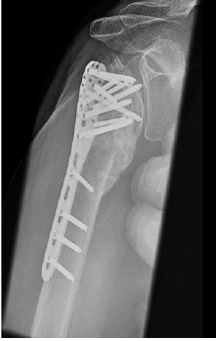
Figure 18. Complication Type 4a. a.p. radiograph of the right shoulder after angular stable plate osteosynthesis shows necrosis of the humeral head. The glenoid articular surface is still intact.